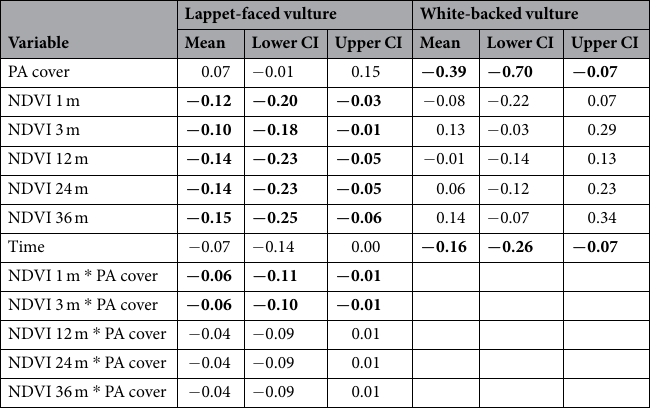
Table 1. Summary of the posterior marginal distributions for Bayesian hierarchical models exploring the relationship between the body condition of lappet-faced and white-backed vulture nestlings in relation to the proportion of area protected (PA cover), and the normalized difference vegetation index (NDVI). We calculated NDVI at five temporal scales representing the situation during the one month prior to the measurement (NDVI 1 m) and up until 3 years prior to the measurement (NDVI 36 m) and modeled these separately. PA cover and the NDVI refer to the area within a 50 km radius around the nest (see methods). The variable named time aimed to depict continuous inter-annual trends in body condition. Each variable and related statistics are derived from separate models including only that variable and time as continuous in the fixed part of a model (see methods and Appendix S1). The statistics for the main variables effects were derived from models without interactions. Values represent the mean of the posterior distribution with upper and lower 95% credibility intervals. Variables for which the credibility intervals do not overlap zero are shown in bold